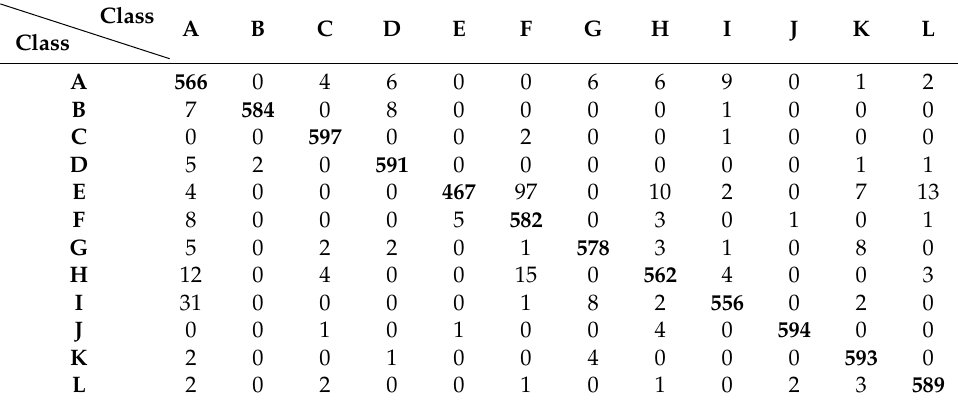
Table 8. Classification result after combination using Product